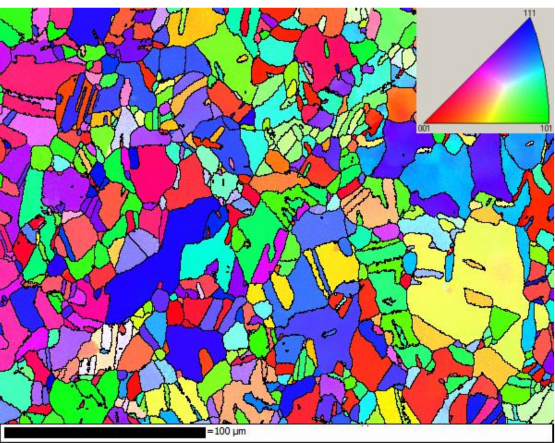
Figure 1. The grain structure of the sample colored by (IPF) with axis vertical to the grain structure map. The Laue raster scanning over the sample was performed in beamline 4B of Pohang Light Source (Pohang, South Korea). The raster scanning was over a V × H grid with the vertical direction parallel to the fatigue loading wherein V = 64 and H = 146. The step size was 2 µ m in both the horizontal and vertical directions of the grid. The obtained Laue microdiffraction pattern was extremely blurred with almost no discernable diffraction peaks (Figure 2a).